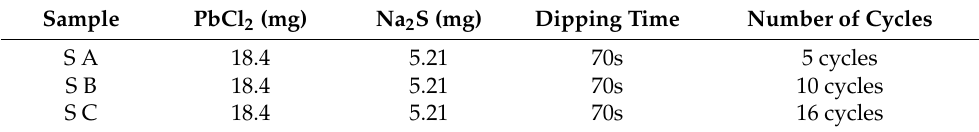
Table 1. Parameters used for SILAR.